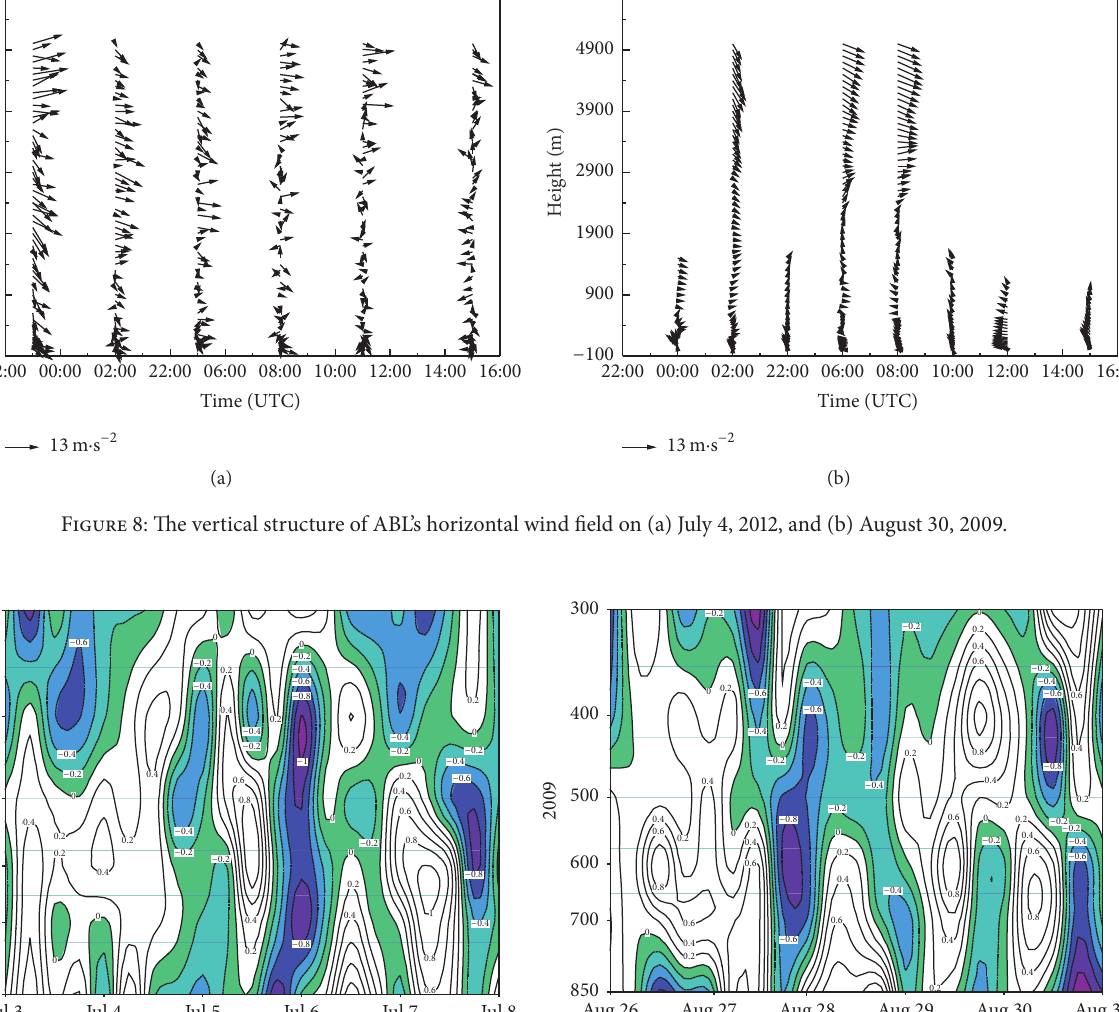
Figure 9: The vertical variation of divergence field during the observation period (a) midsummer and (b) late summer.